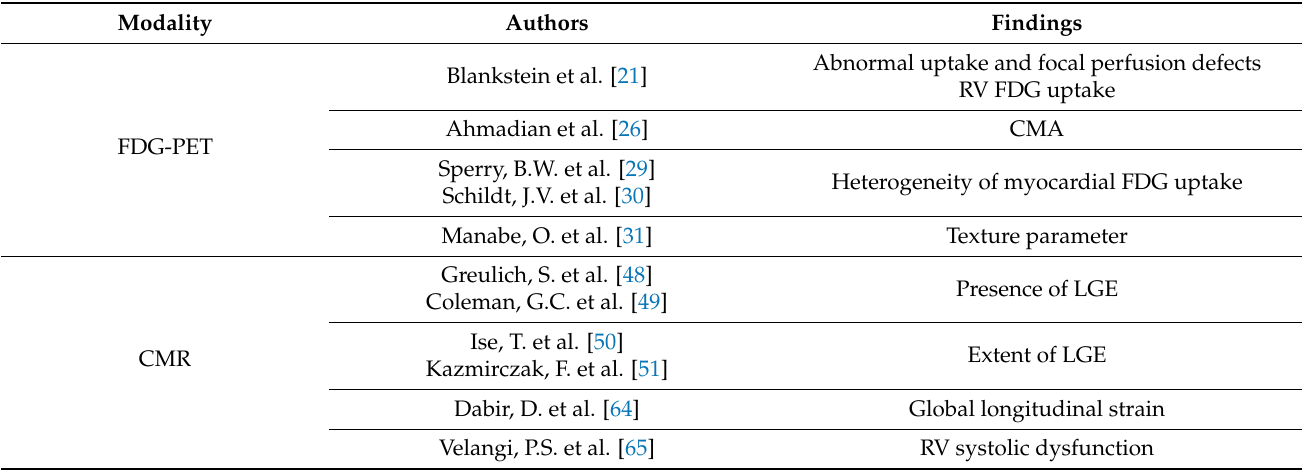
Figure 5. CMR feature-tracking analysis. Findings for the same patient as in Figure 1. Each regional strain is presented in the same colored curve, and the white curve represents the average of all regions. Inhomogeneous longitudinal strain due to cardiac sarcoidosis not only in the LV wall but also in the RV wall. LV, left ventricular; RV, right ventricular. Table 6. Imaging evaluation relating to prognosis and/or cardiac events.